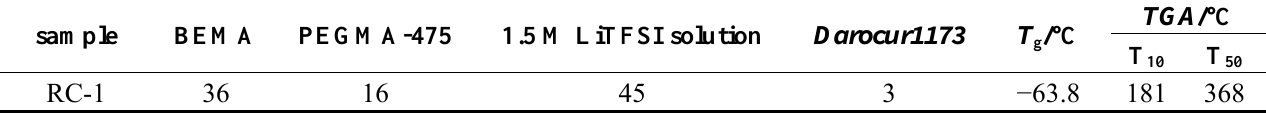
Table 1. Exact compositions (in wt.%) of the reactive mixture used to prepare sample RC-1, along with its thermal